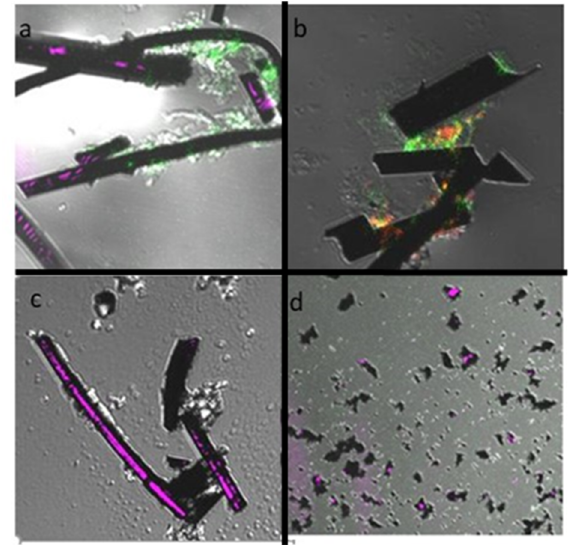
Figure 7. CLSM images of ( a ) gamma Proteobacteria spp. (purple) and delta Proteobacteria spp. (green) bacteria. ( b ) Archaeal (red) and Eubacterial (green) bacteria within the biofilm ( c ) Geobacter spp. cluster (felt) ( d ) Geobacter spp. cluster (graphite).